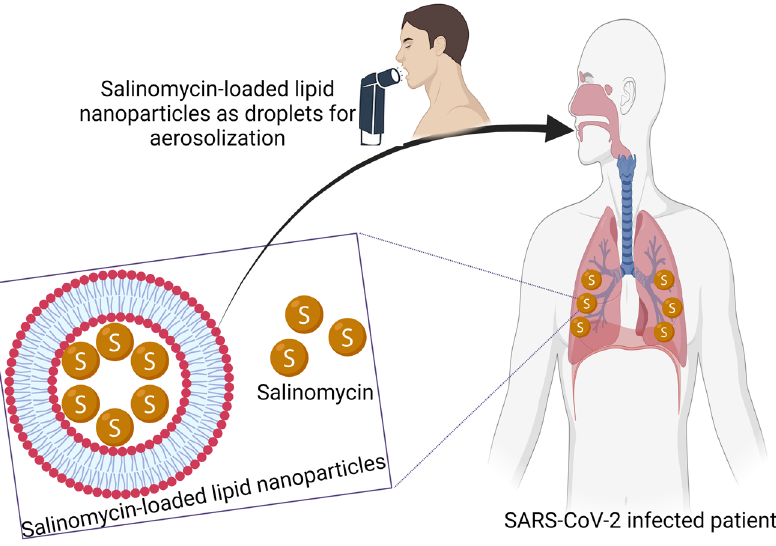
Figure 6: Lipid - based nanoparticles for pulmonary salinomycin delivery in the treatment of COVID - 19 infected